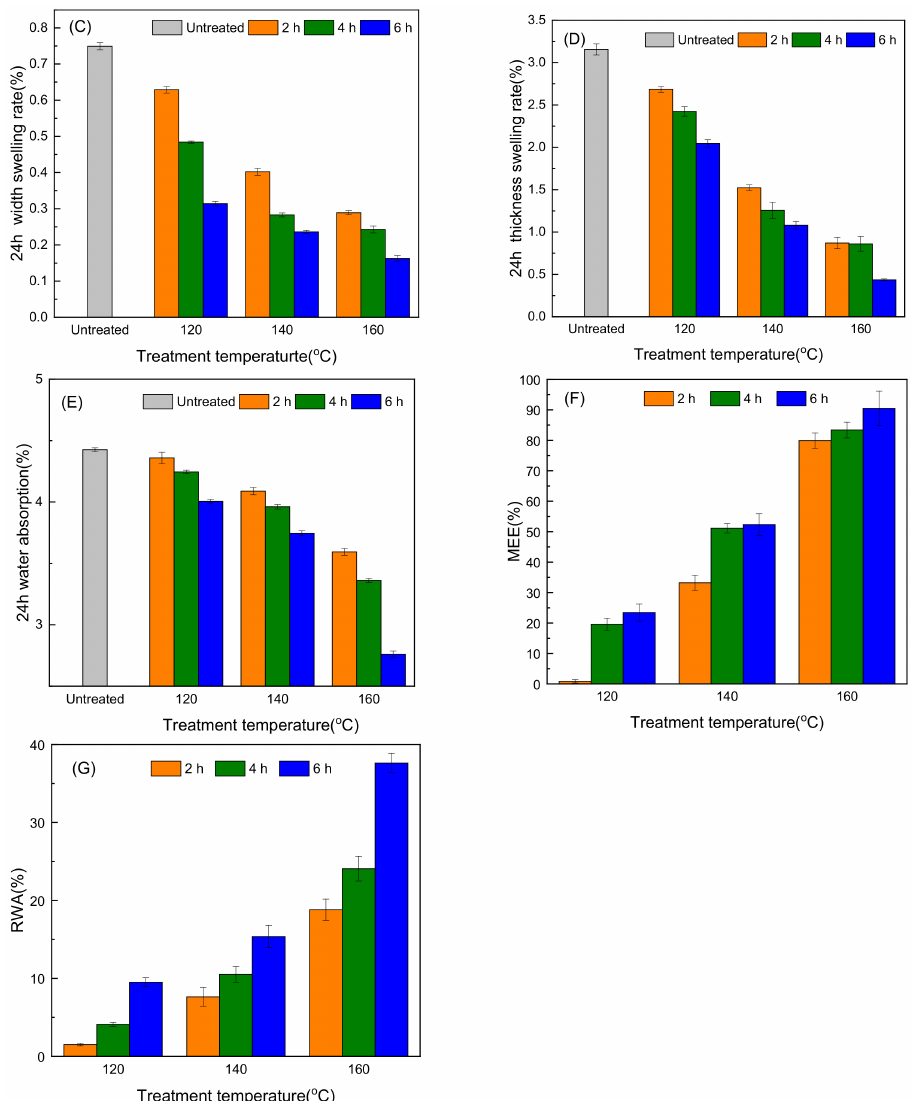
Figure 3. ( A ) The density of bamboo scrimber, ( B ) air-dried moisture content, ( C ) the 24 h width swelling rate, ( D ) the 24 h thickness swelling rate, ( E ) the 24 h water absorption, ( F ) moisture excluding e ffi ciency (MEE), and ( G ) resistance to water absorption (RWA). Error Bars Represents the Standard Deviation of the